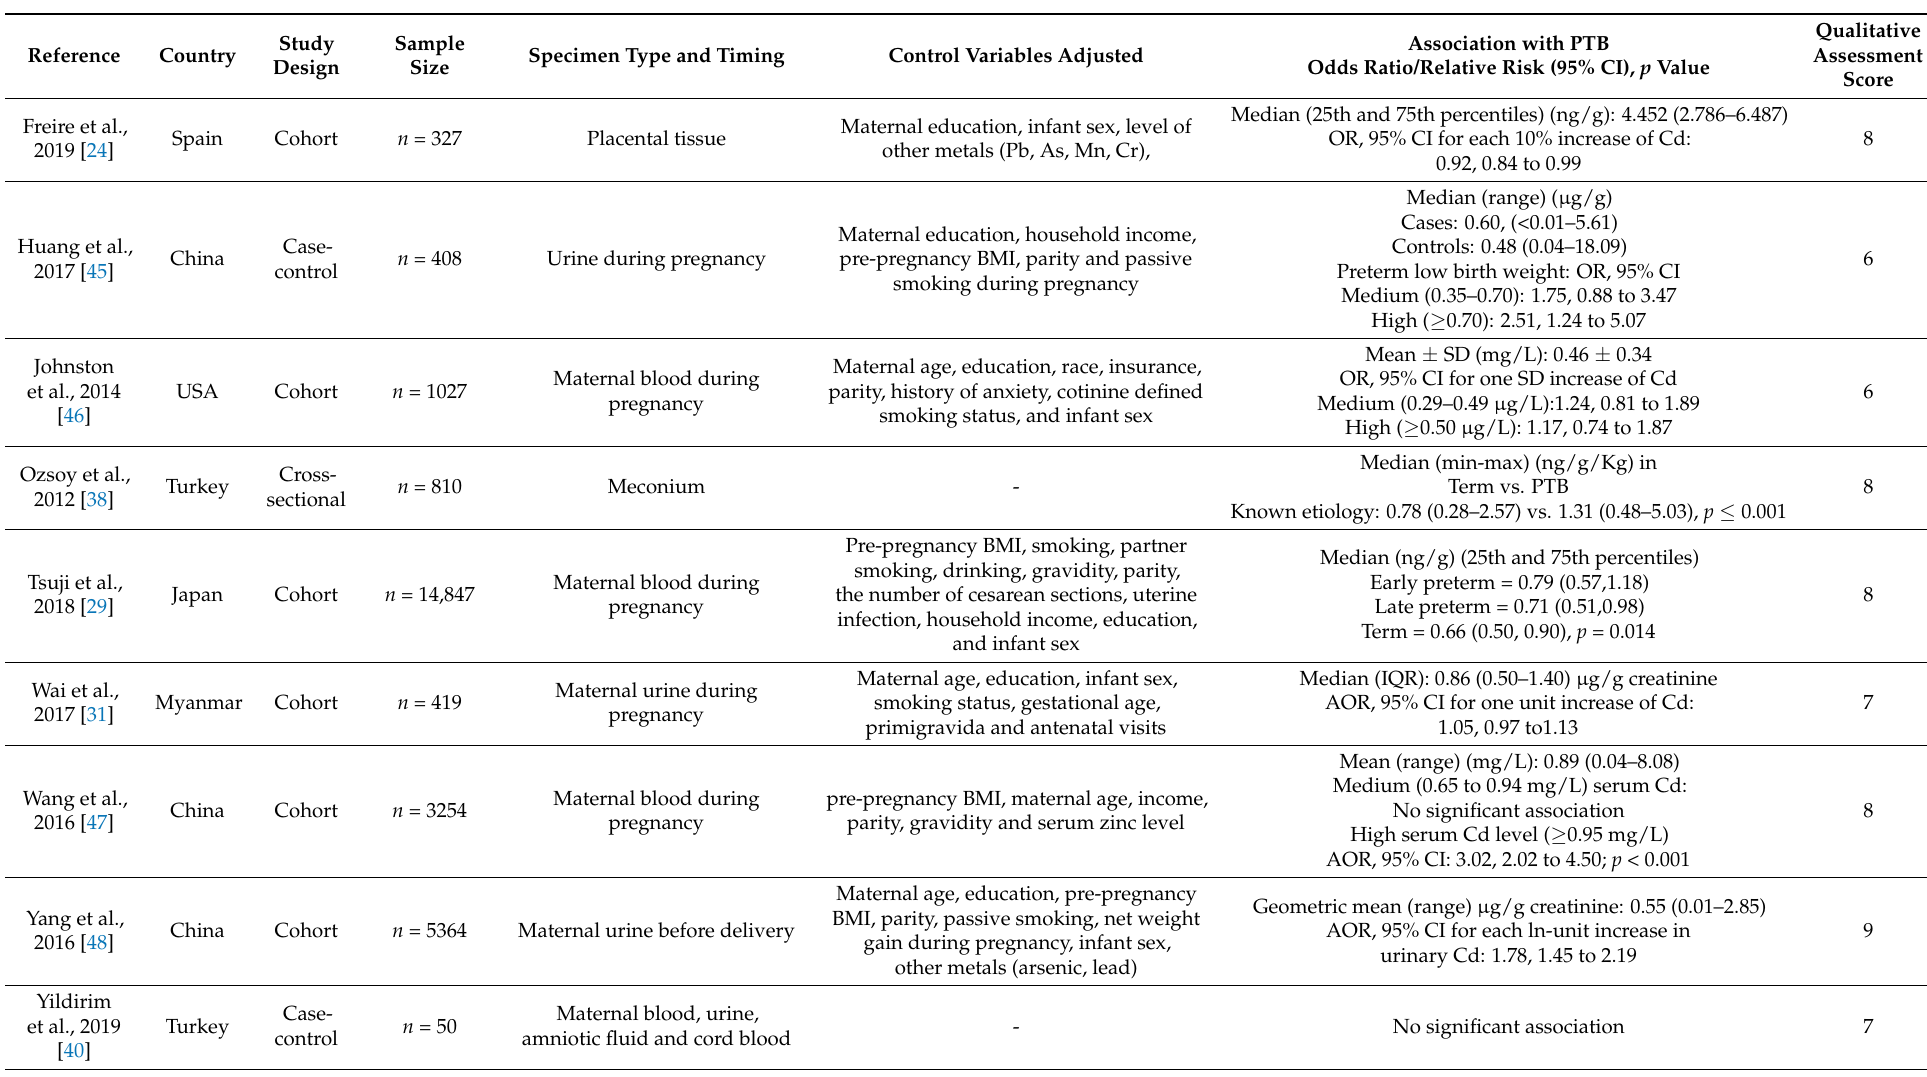
Table 3. Association between Cadmium and